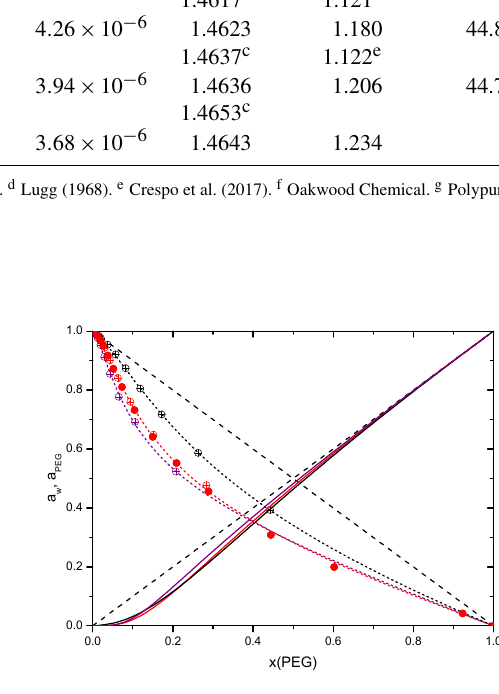
Figure 1. Water and PEG activities vs. mole fraction of PEG for PEGs with three different mean molar masses: PEG200 (black), PEG400 (red), and PEG600 (purple). Filled data points are from this study; open symbols from Ninni et al. (1999). The dashed, black lines illustrate ideal behavior, the short dashed lines are van Laar fits to the water activity data, and the solid lines are the PEG activities obtained from the van Laar fits using the Gibbs–Duhem